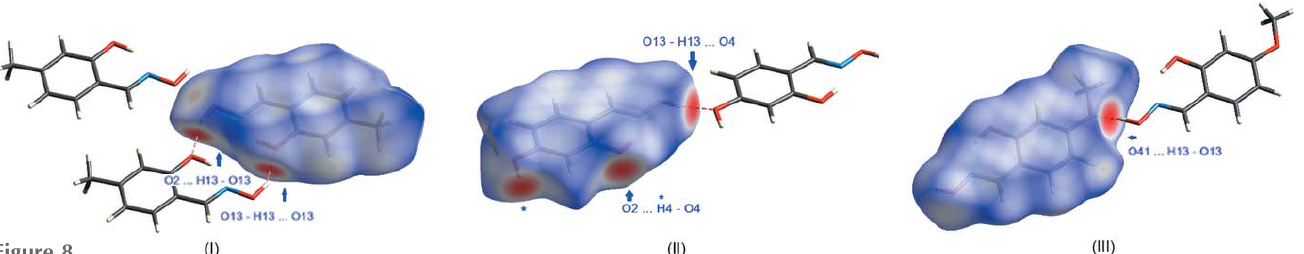
Figure 8 Views of the Hirshfeld surfaces mapped over d norm for 1 – 3 . In each case, the red areas relate to classical hydrogen bonds.